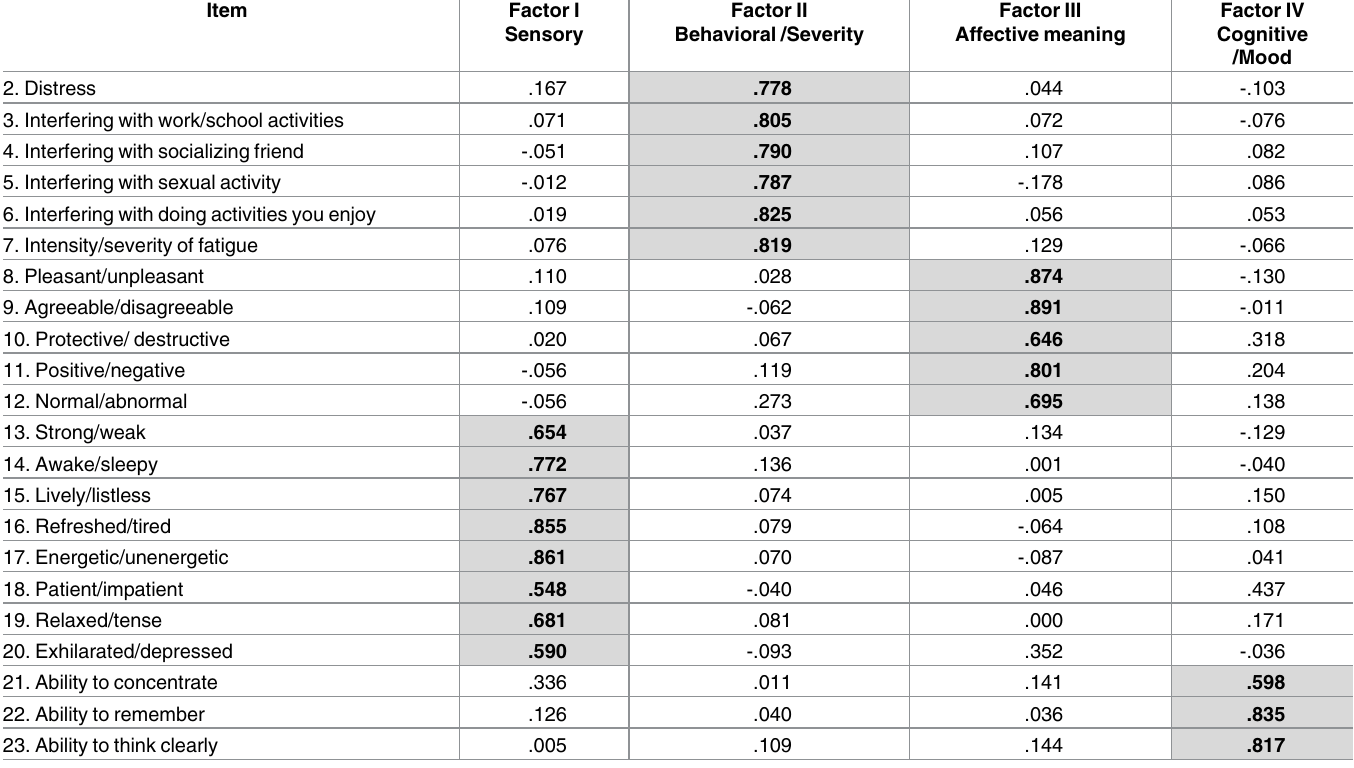
Table 2. Factor loading for total